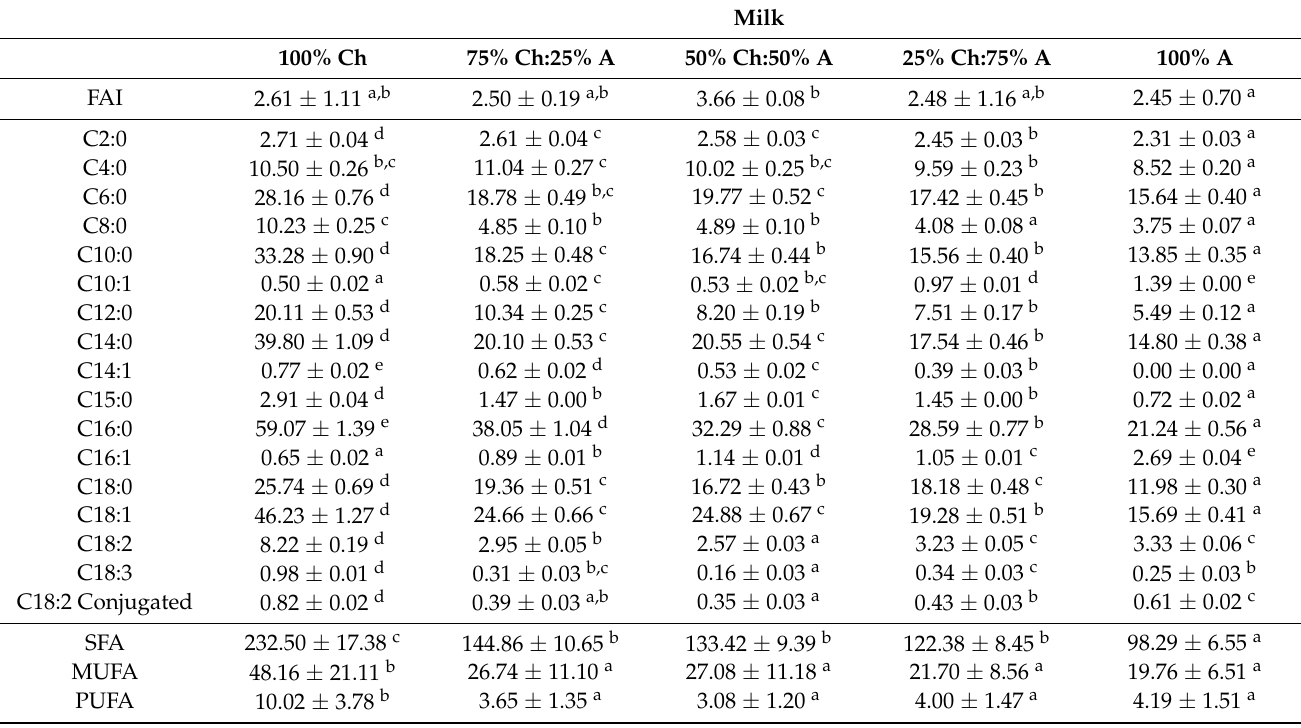
Table 3. Free fatty acids (FFA) content in Zamorano cheese made with milk from Churra (Ch) and Assaf (A) breed after 240 days’